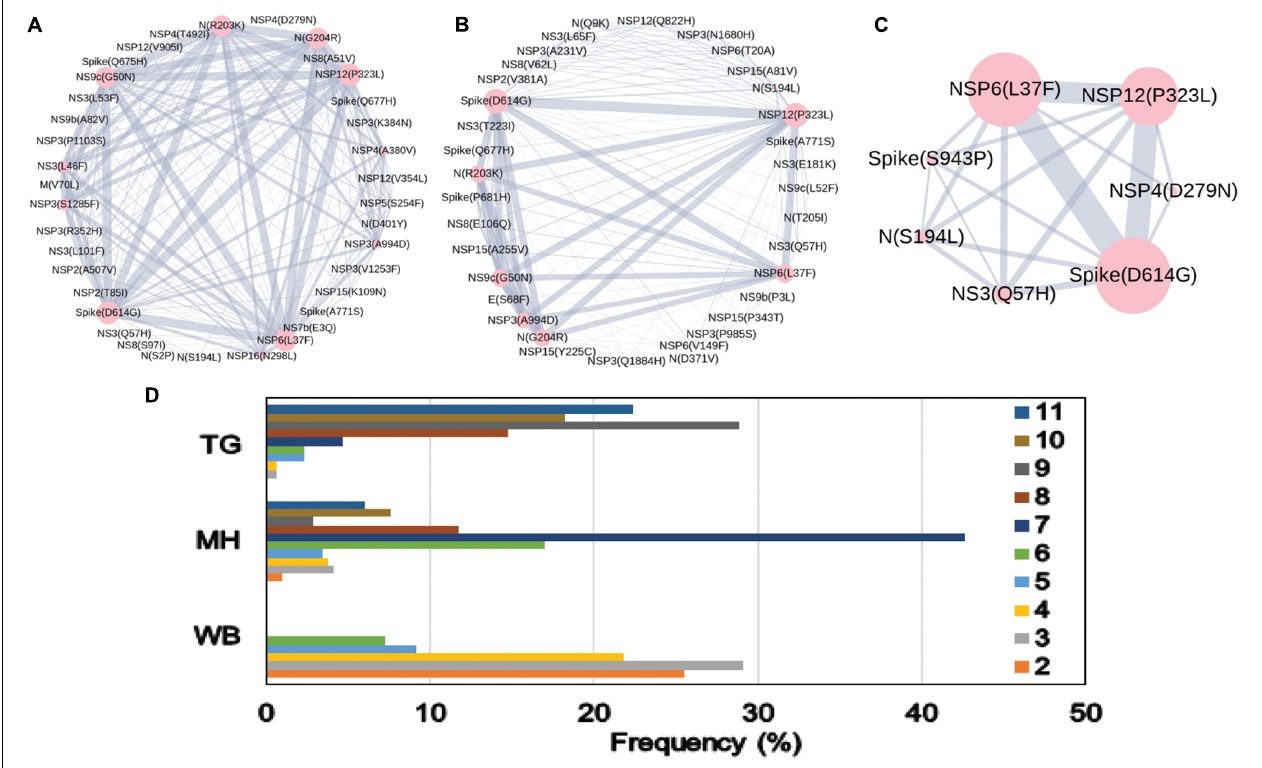
FIGURE 4 | Co-mutation patterns and networks observed within Indian states and union territories during Term3. (A–C) The networks of co-mutations for Telangana, Maharashtra, and West Bengal, respectively, where each mutation site is marked as a “node” and the co-mutation is represented as an “edge.” The node size indicates the frequency of mutation, while the edge thickness represents the number of times (sequences) a pair of mutation has co-occurred. (D) The bar plot distribution of the actual number of co-mutations within each